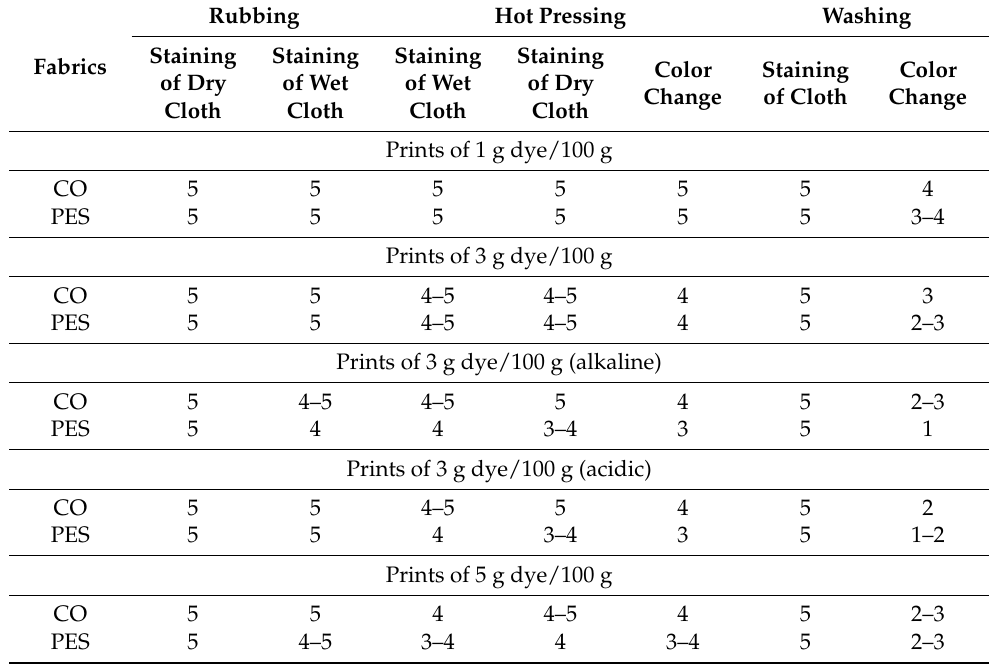
Table 4. Colorfastness of prints on fabrics to dry and wet rubbing, wet hot pressing, laundering at 40 ◦ C.